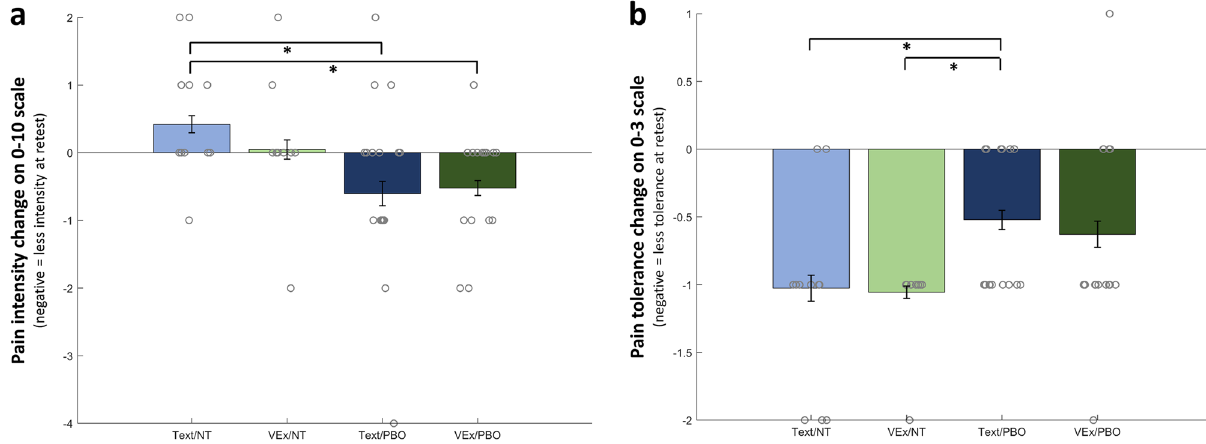
Figure 7. Changes in in retrospective ratings between baseline and retest for the four groups. Grey circles are single data points (score differences). Legend: *, p < 0.05. ( a ) Retrospective pain intensity ratings. ( b ) Retrospective pain tolerance